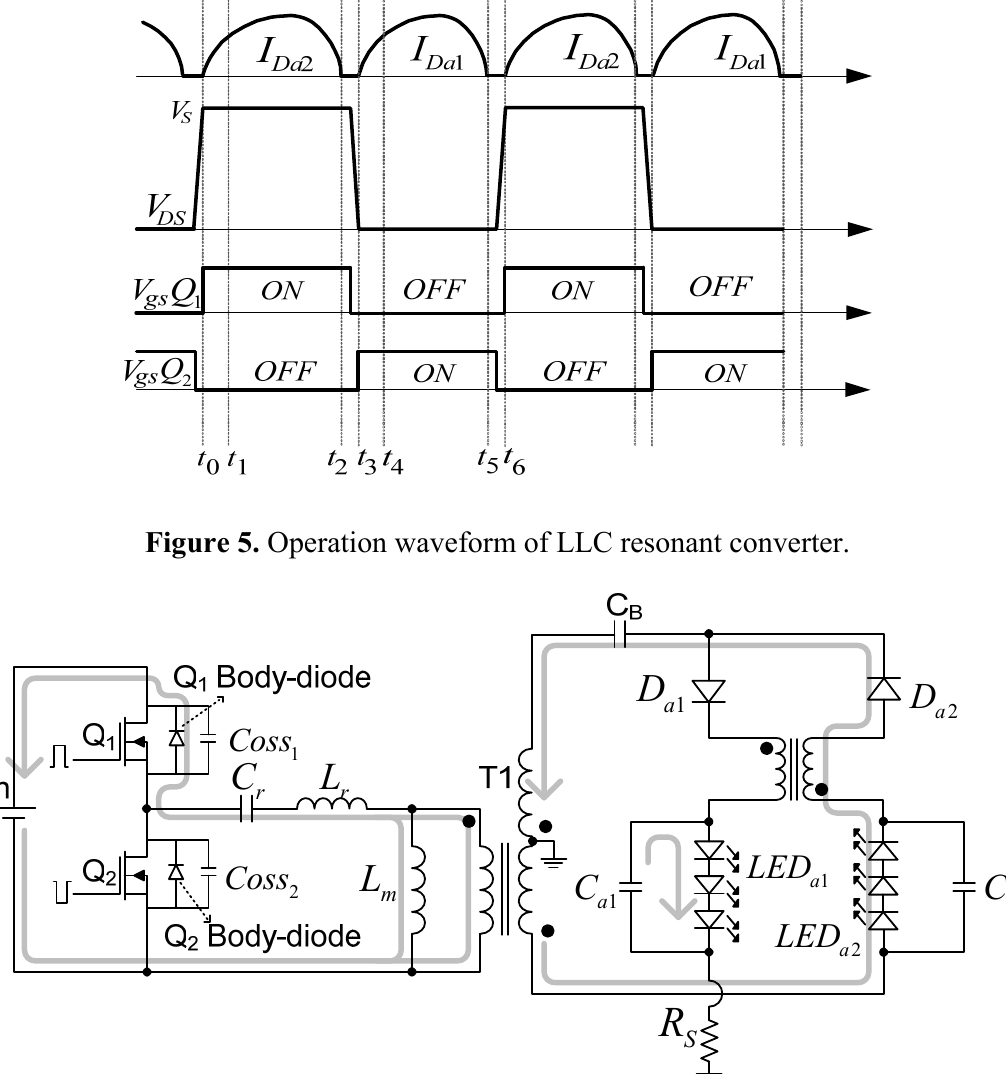
Figure 6. Circuit diagram during Mode